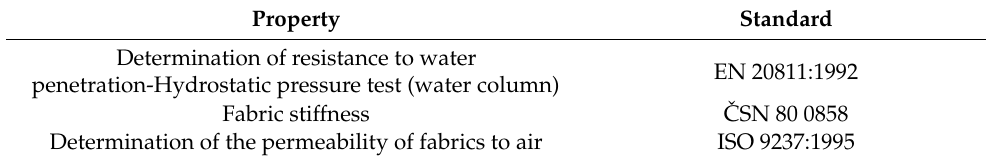
Table 3. Standards employed to evaluate the properties of the coated